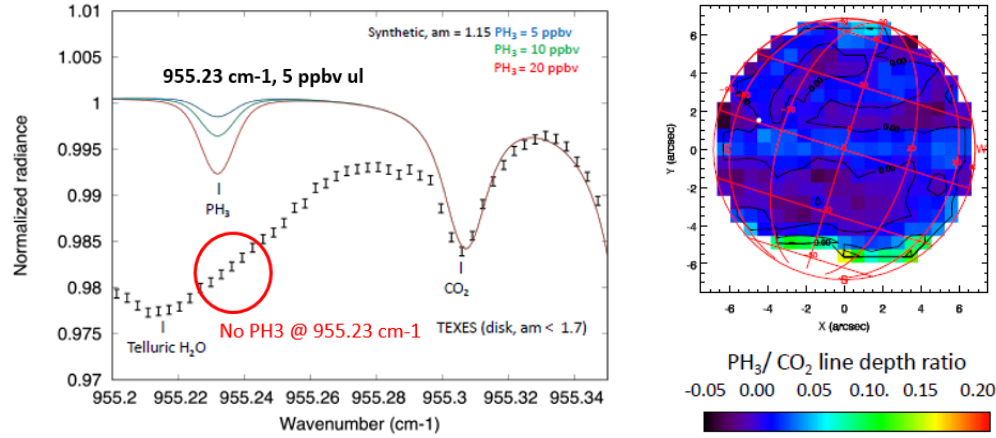
Figure 2. ( Left panel ) Disk-integrated spectrum of Venus between 955.2 cm − 1 and 955.4 cm − 1 . A CO 2 line is detected on Venus, at approximately 955.31 cm − 1 and telluric water absorption dominates the spectrum, at 955.2–955.28 cm − 1 , precluding the detection of the phosphine absorption line, which should be detectable within the red circle. An upper limit of 5 ppb for the abundance of phosphine was obtained. ( Right panel ) Map of the PH 3 /CO 2 line depth ratio across the Venusian disk. (images credits: Encrenaz et al.